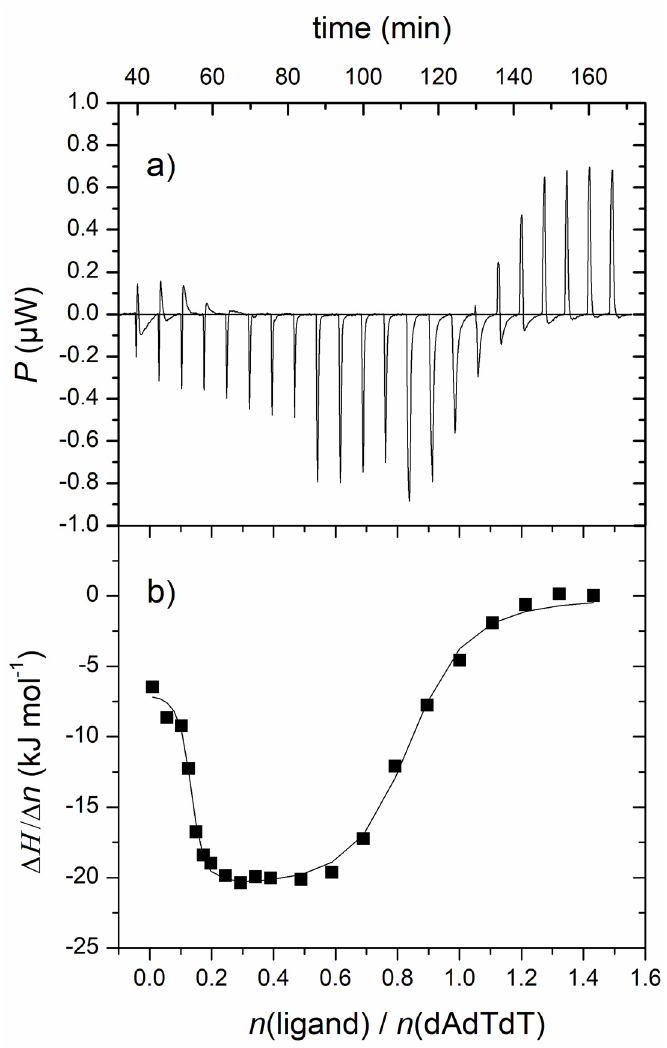
Figure 4. ( a ) Raw titration data from the single injection of 1 into a solution of ATT triplex; ( b ) ITC experiment of ATT triplex titrated with 1 ; experimental data ( (cid:4) ) and calculated fit (–) for model of two sets of sites. [ATT] = 3.0 × 10 − 5 M; pH = 7.0, Na-cacodylate buffer, I = 0.05 mol dm − 3 + 1 mM EDTA.